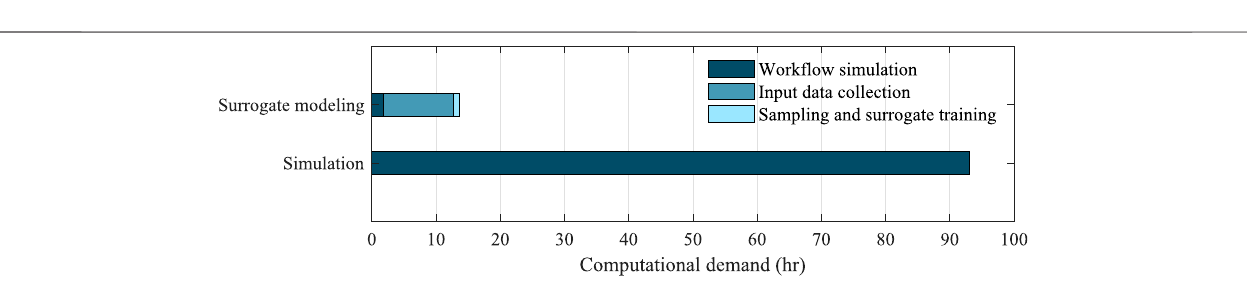
Frontiers in Built Environment |